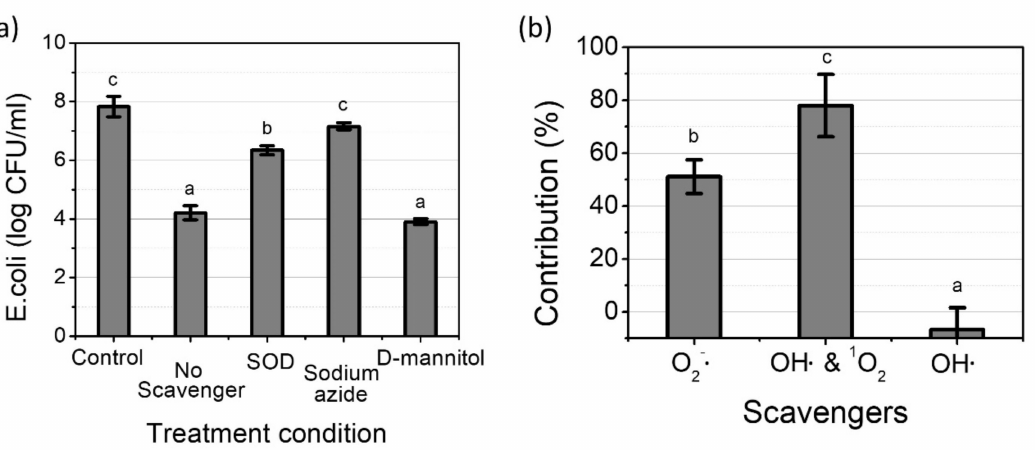
Figure 5. The effect of scavengers on E. coli after a plasma treatment with a 1-mm gap; ( a ) surviving E. coli population with different scavengers; ( b ) contribution ratio of each short-lived species. Results are presented as the mean ± standard deviation from three independent experiments. Different letters indicate significant differences ( p <